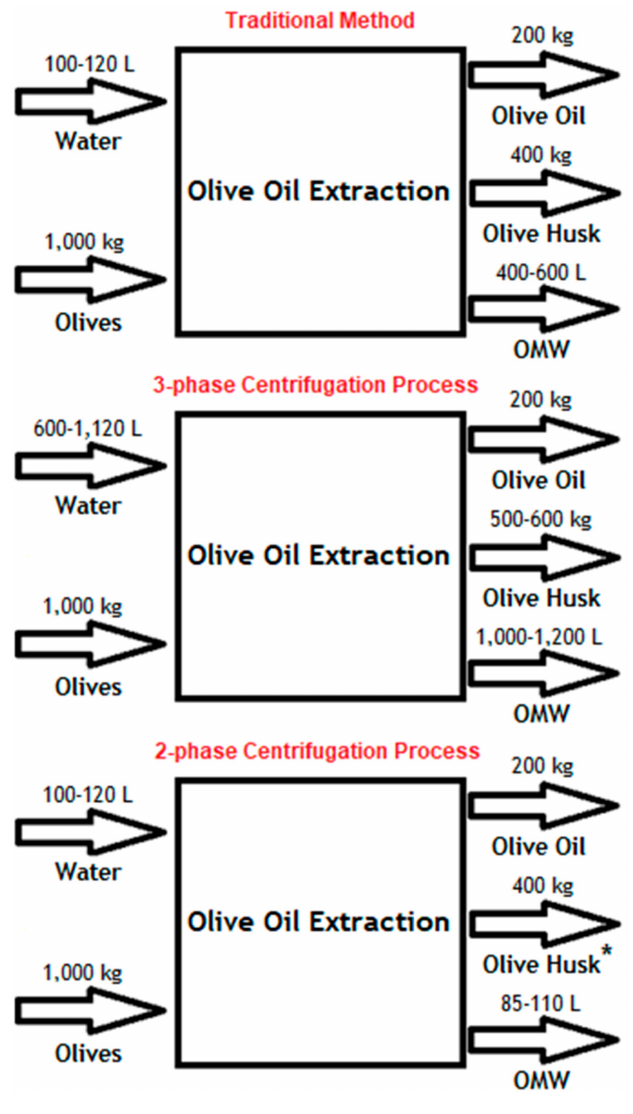
Figure 4. A quantitative relationship between the OMW production and the remaining components present in the olive oil extraction. * The olive husk mass presented in the two-phase centrifugation pro- cess does not include the mass lost in secondary drying processes. Data taken from Caputo et al. [14]. These big amounts of OMW cause large environmental problems [15–18]. It is reported